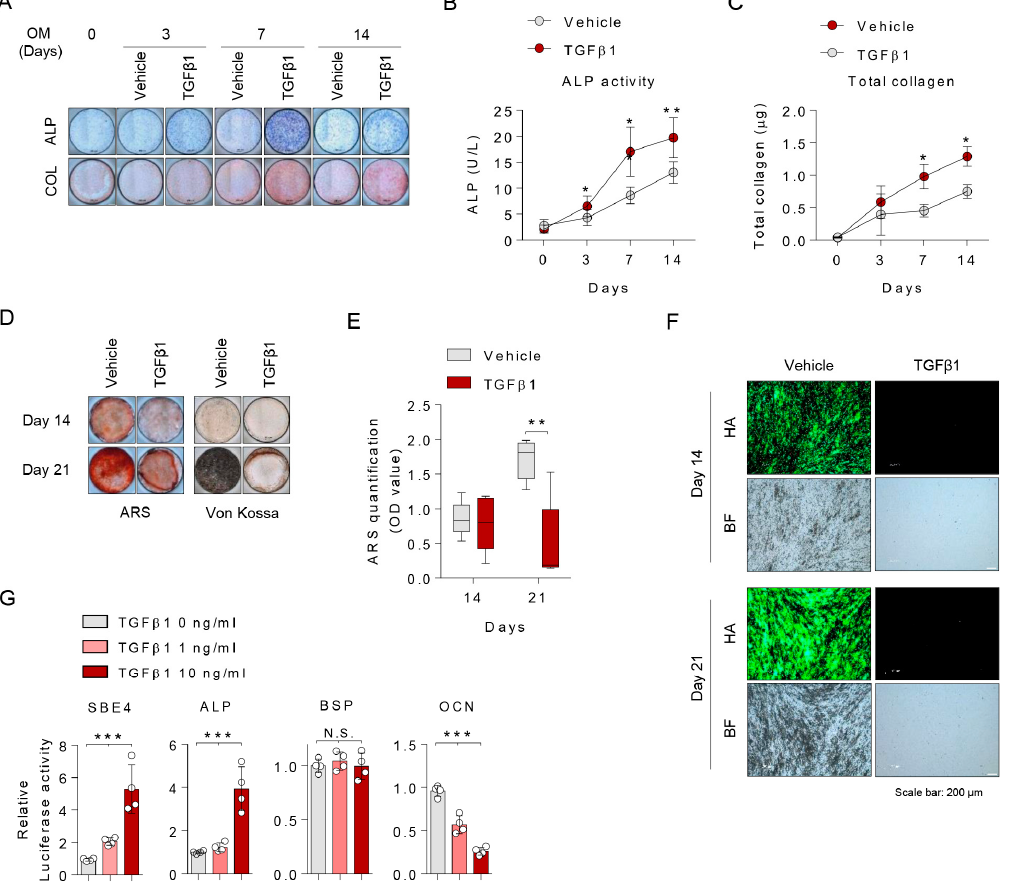
Figure 1. Transforming growth factor β 1 (TGF β 1) promotes extracellular matrix maturation in the early stage and suppresses mineralization in the late stage of osteogenic di ff erentiation. Osteoprogenitors were di ff erentiated into osteoblasts and continually stimulated by Vehicle or TGF β 1 (10 ng / mL) during osteoblasts di ff erentiation. At the indicated days, osteogenic di ff erentiation activity was assessed by ( A ) alkaline phosphates (ALP) and collagen (COL) staining; scale bar is 200 µ m, ( B ) ALP activity of ( A ), ( C ) total collagen contents of ( A ), ( D ) Alizarin red staining (ARS) and von Kossa staining, ( E ) ARS quantification of ( D ), and ( F ) hydroxyapatite (HA) staining. All images are representative from the five independent experiments. ( G ) 293T cells were transfected with the promoter plasmids indicated for 48 h, treated with 1 and 10 ng / mL TGF β 1 for 24 h, and then analyzed with a luciferase assay ( n = 4). * p < 0.05; ** p < 0.01; *** p < 0.001; N.S. Not significant. Values are expressed as the mean ± SEM (Student’s two-tailed t -test).